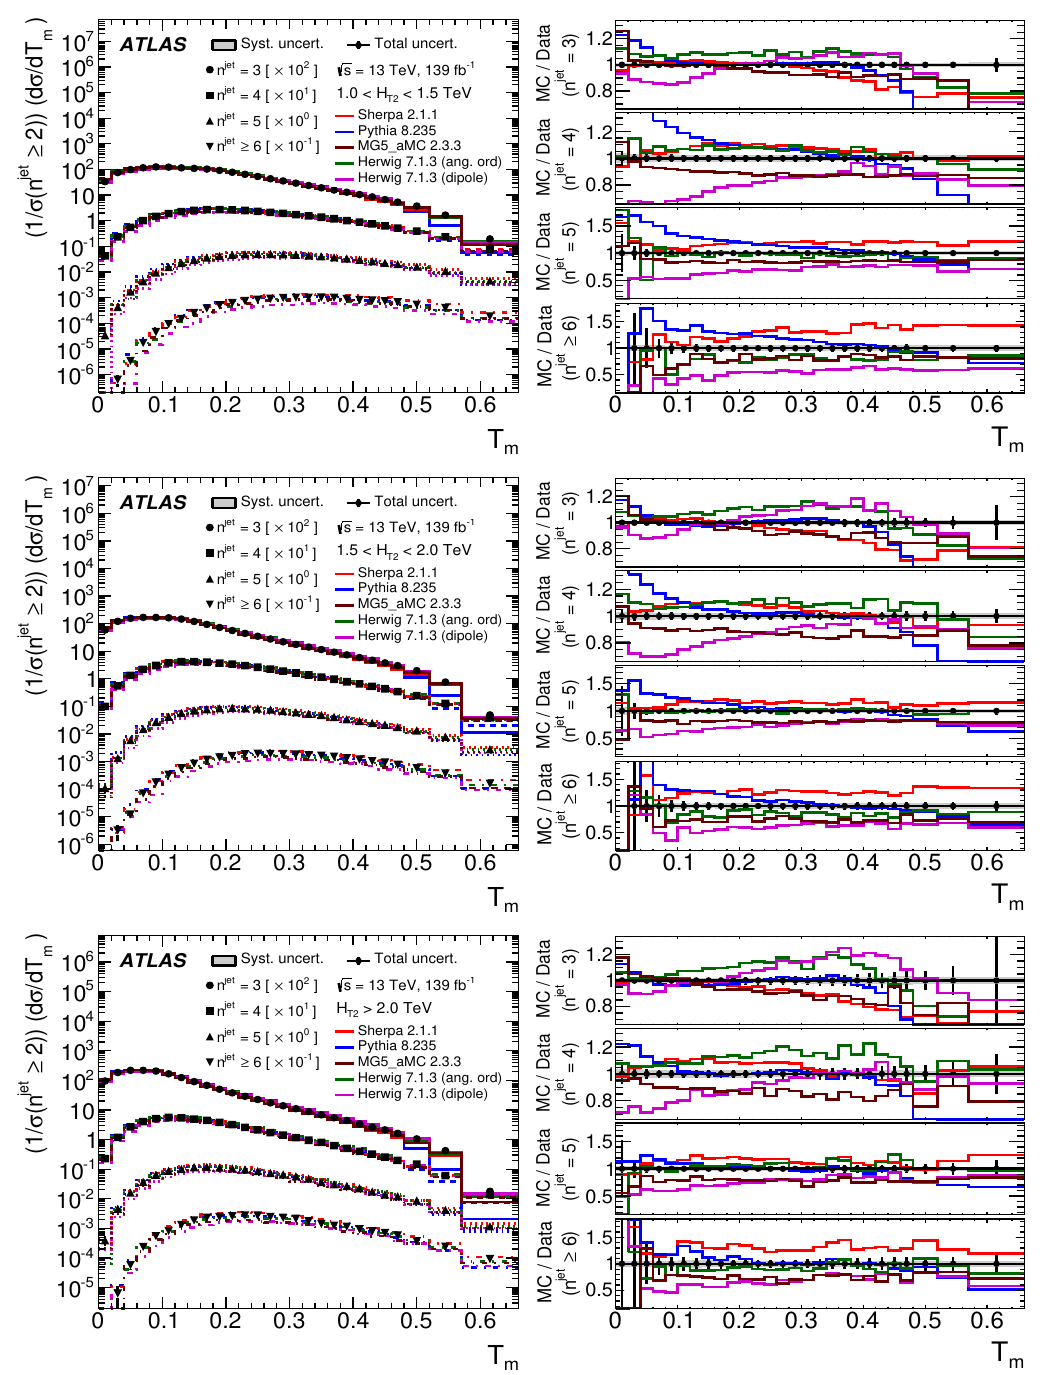
Figure 6 . Comparison between data and MC predictions as a function of the transverse minor T m (see eq. 3.1) for different jet multiplicities and energy scales. For illustration purposes, the corresponding differential cross section for each jet multiplicity is multiplied by 10 2 ( n jet = 3), 10 1 ( n jet = 4), 10 0 ( n jet = 5), 10 − 1 ( n jet ≥ 6). The right panels show the ratios between the MC and the data distributions. The error bars show the total uncertainty (statistical and systematic added in quadrature) and the grey bands in the right panels show the systematic